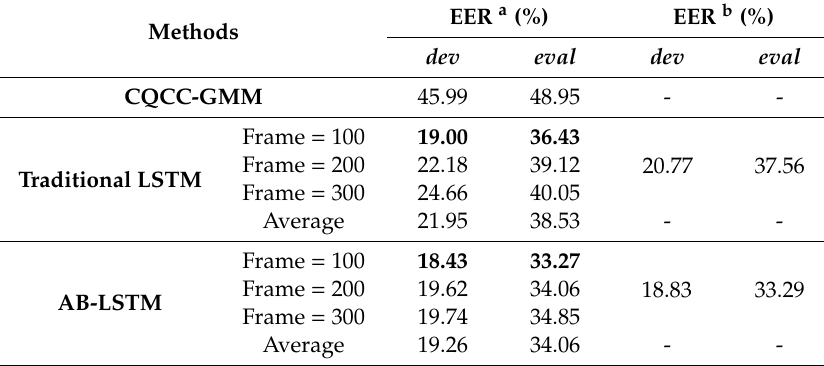
Table 6. EER a (%) and EER b (%) for di ff erent methods when SNR = 5 dB.